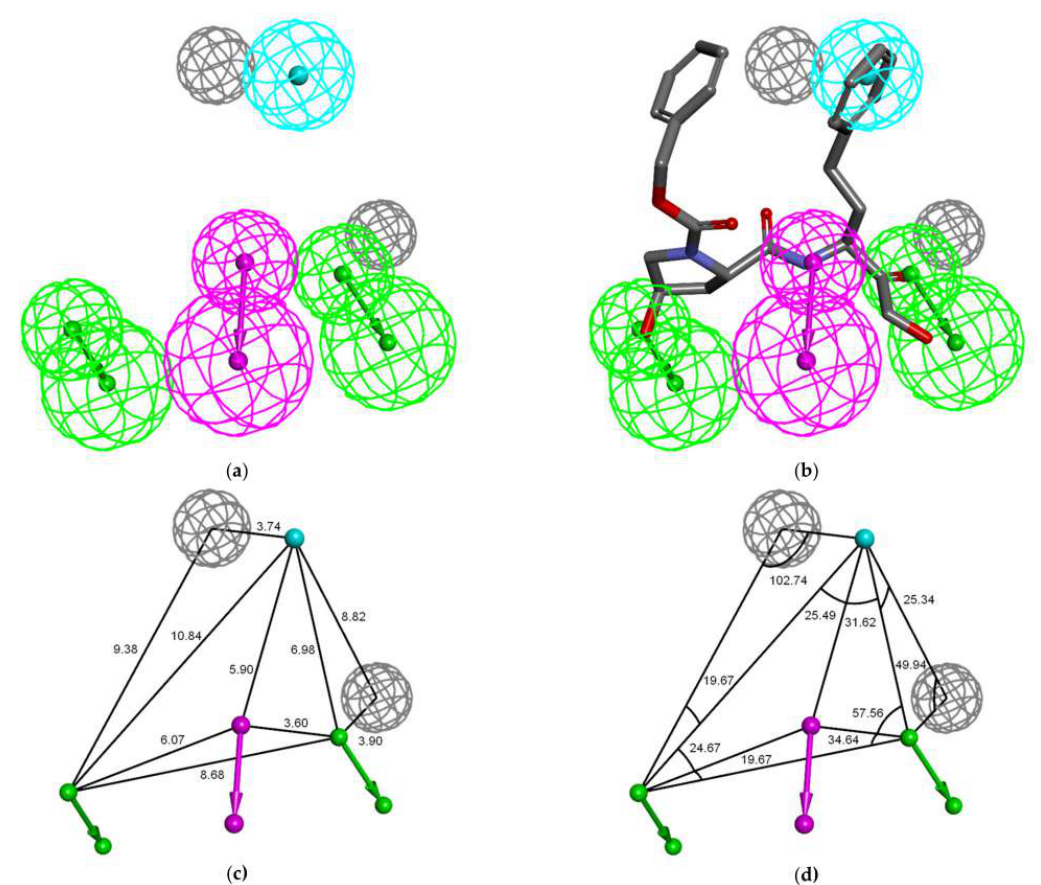
Figure 5. ( a ) Features of the Hypo1 pharmacophore of FP3 inhibition; ( b ) pharmacophore mapping by the most active of the training set PEP39; ( c ) inter-features distances in Å; ( d ) angles between features. Colours legend of features: hydrophobic (blue), hydrogen bond acceptor (green), hydrogen bond donor (purple), excluded volumes